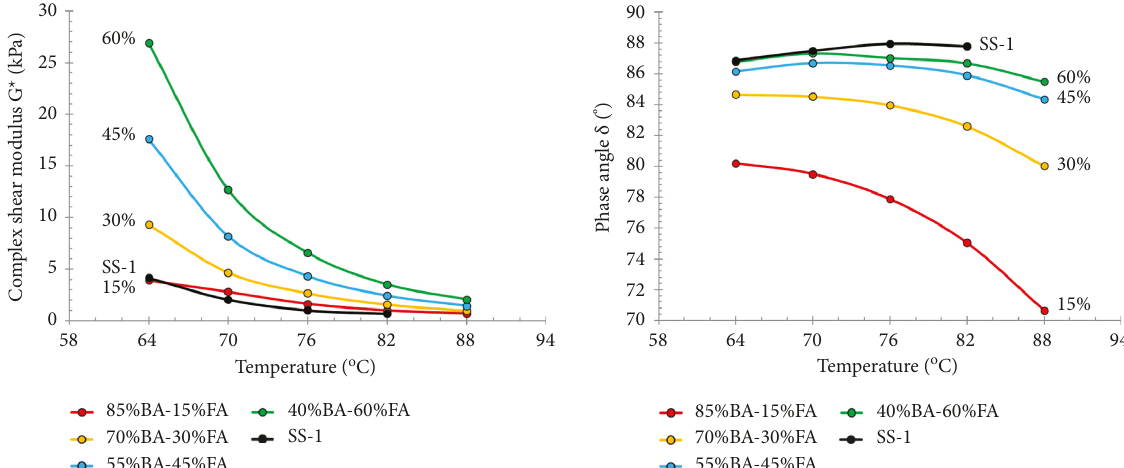
Figure 5: DSR results, shear modulus, and phase angle @ 1.59Hz, of the residual bitumen from the emulsion (SS-1) and fly ash mixes with mixing method 1.